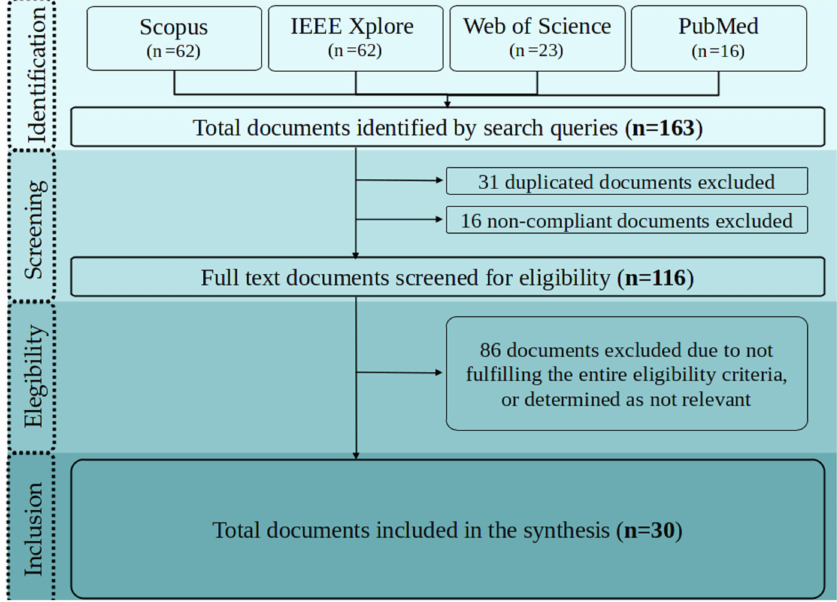
Figure 1. Searching, filtering, and selection of papers to be included in the review, following the PRISMA methodology [21].